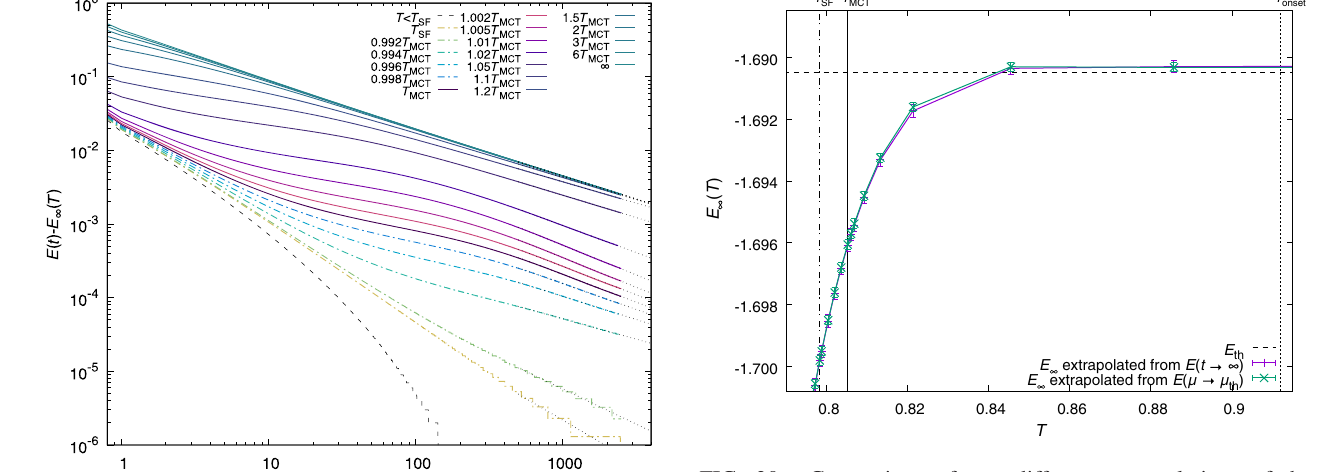
FIG. 30. Comparison of two different extrapolations of the asymptotic energies E ∞ ð T Þ , obtained by fitting versus t and − μ ð t Þ . versus μ mg